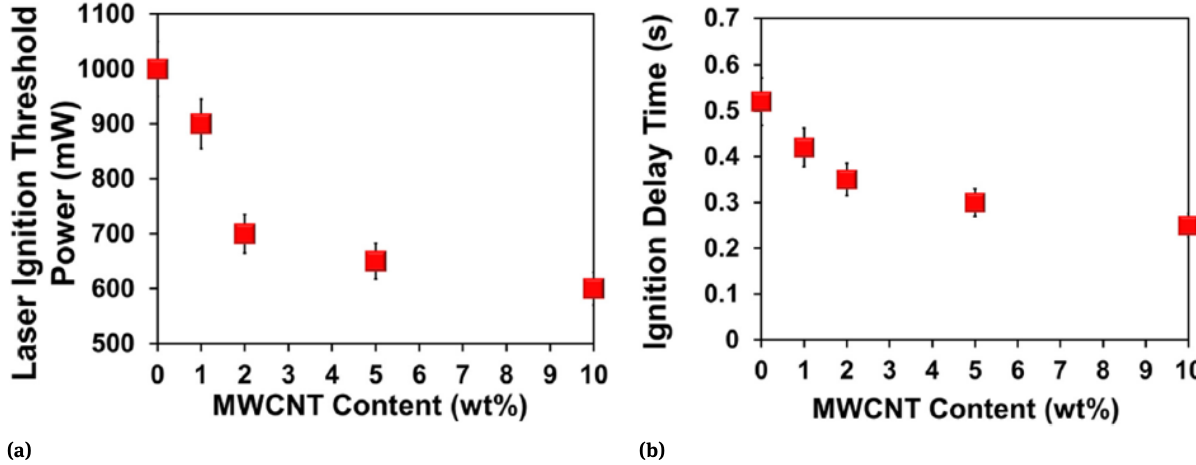
Figure 4: Laser ignition power thresholds as function of MWCNT weight ratio in Al NP/CuO NP composite samples (a), and ignition delay of MWCNT/Al NP/CuO NP sample depending on the MWCNT weight ratio (b)